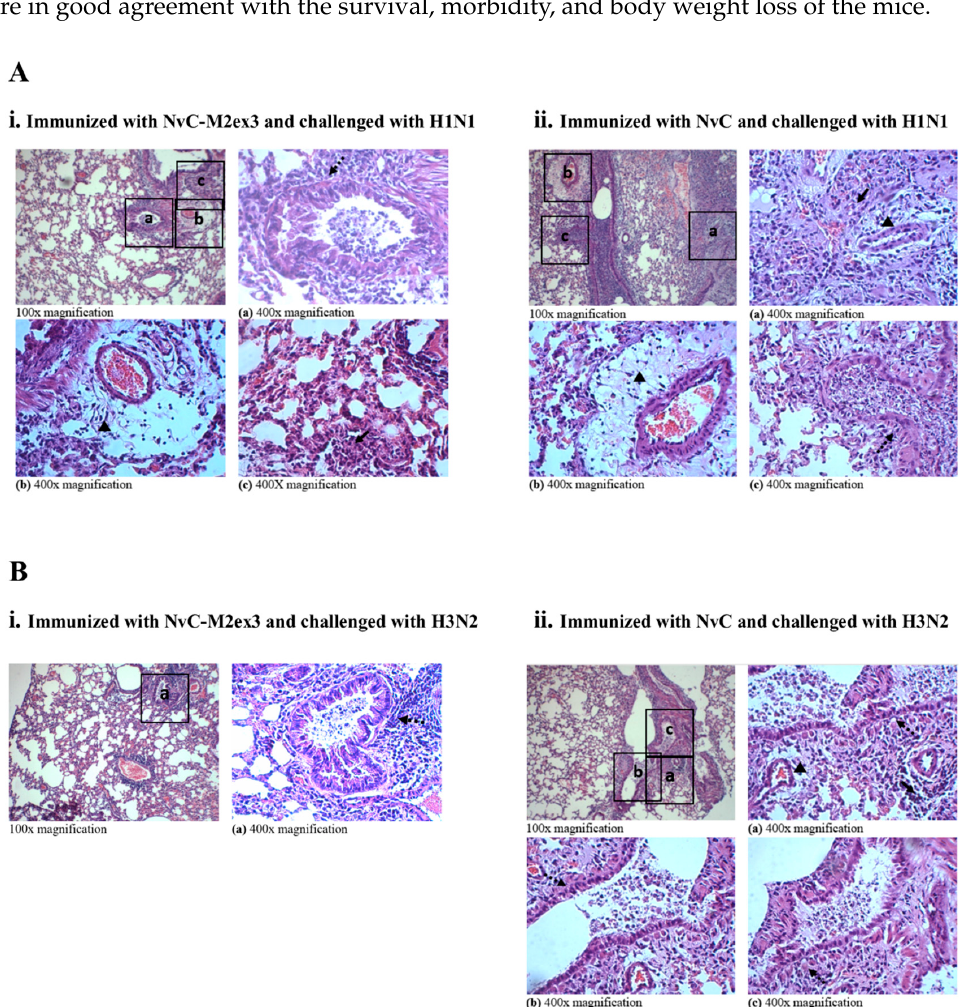
Figure 5. Hematoxylin and Eosin (H and E) staining of the lungs of mice (n = 3) immunized with the chimeric proteins and challenged with influenza A virus H1N1 or H3N2. ( A ) The lungs of mice immunized with (i) NvC-M2ex3 or (ii) NvC at day five post-infection with H1N1. ( B ) The lungs of mice immunized with (i) NvC-M2ex3 or (ii) NvC at day five post-infection with H3N2. Insets with letters (a, b, c) are projected at 400x magnification as (a), (b), and (c). Dashed and solid arrows indicate bronchiolitis and interstitial inflammation respectively, and triangles indicate edema, n =